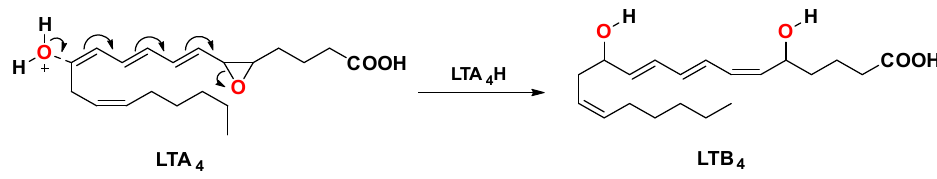
Figure 1. The final rate-limiting step in the biosynthesis of leukotriene B4.